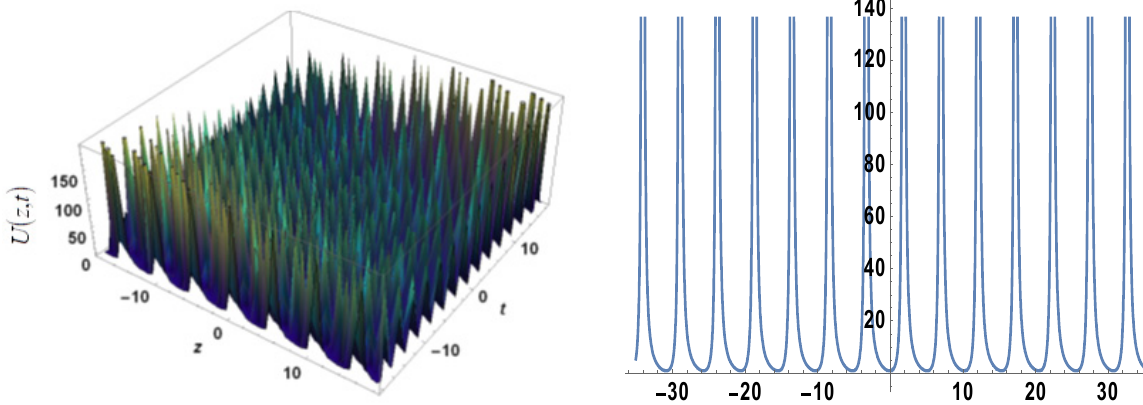
Figure 8. The 3D and 2D plots of Equation (58) for various values of parameters.